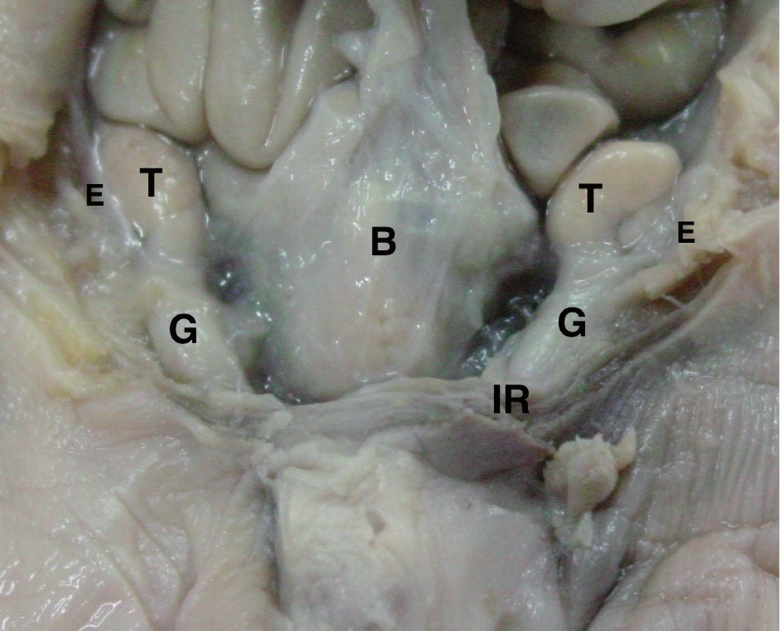
Figure 1 - Image of a male fetus aged 22 weeks post-conception with both testes situated in the abdomen. The abdominal wall was dissected to show the position of the testis (T) above the internal ring (IR). The figure shows the gubernaculum (G) and the bladder